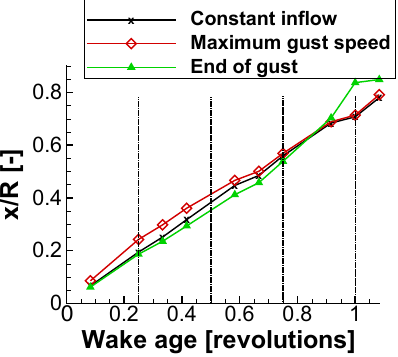
Figure 12. Tip vortex transportation in the main flow direction with dependence on the wake age at three time instances during the gust.